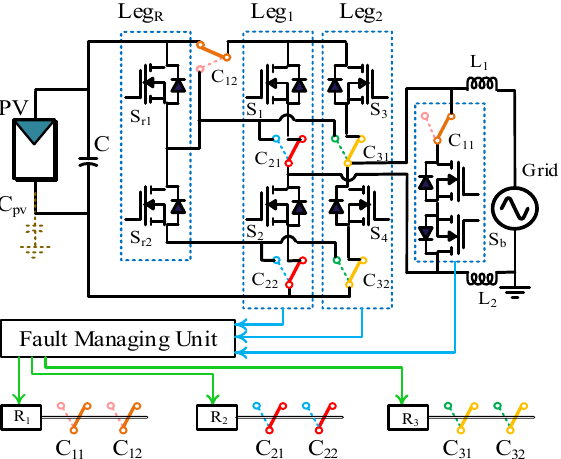
Figure 2. The proposed integrated fault tolerant PV inverter (IFTPVI).